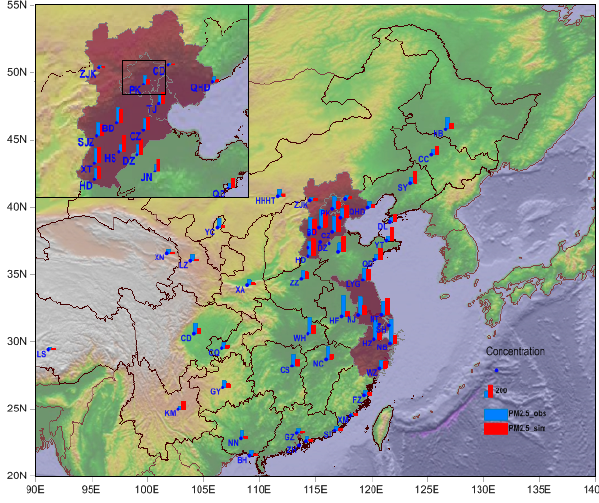
Figure 1. Mean observed and simulated PM 2 . 5 (µgm − 3 ) for 6– 7 December